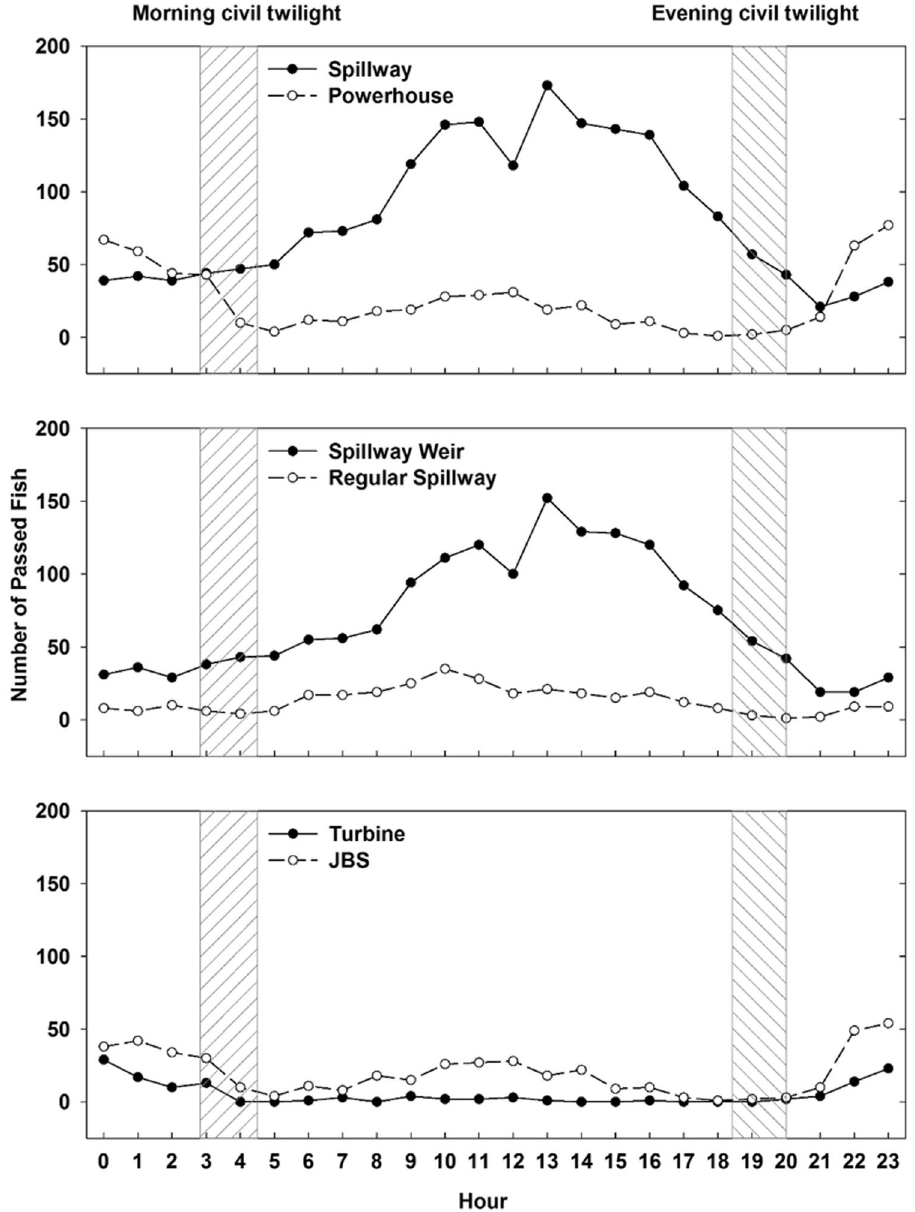
Figure 5. Number of acoustic tagged subyearling Chinook salmon that passed LGS in 2013 for each hour of the day. (Top) Comparison between spillway and powerhouse passage; (Middle) Comparison between spillway weir and regular spillway passage; (Bottom) Comparison between turbine and JBS passage. The dashed areas represents the two periods of civil twilight varying from April to August,